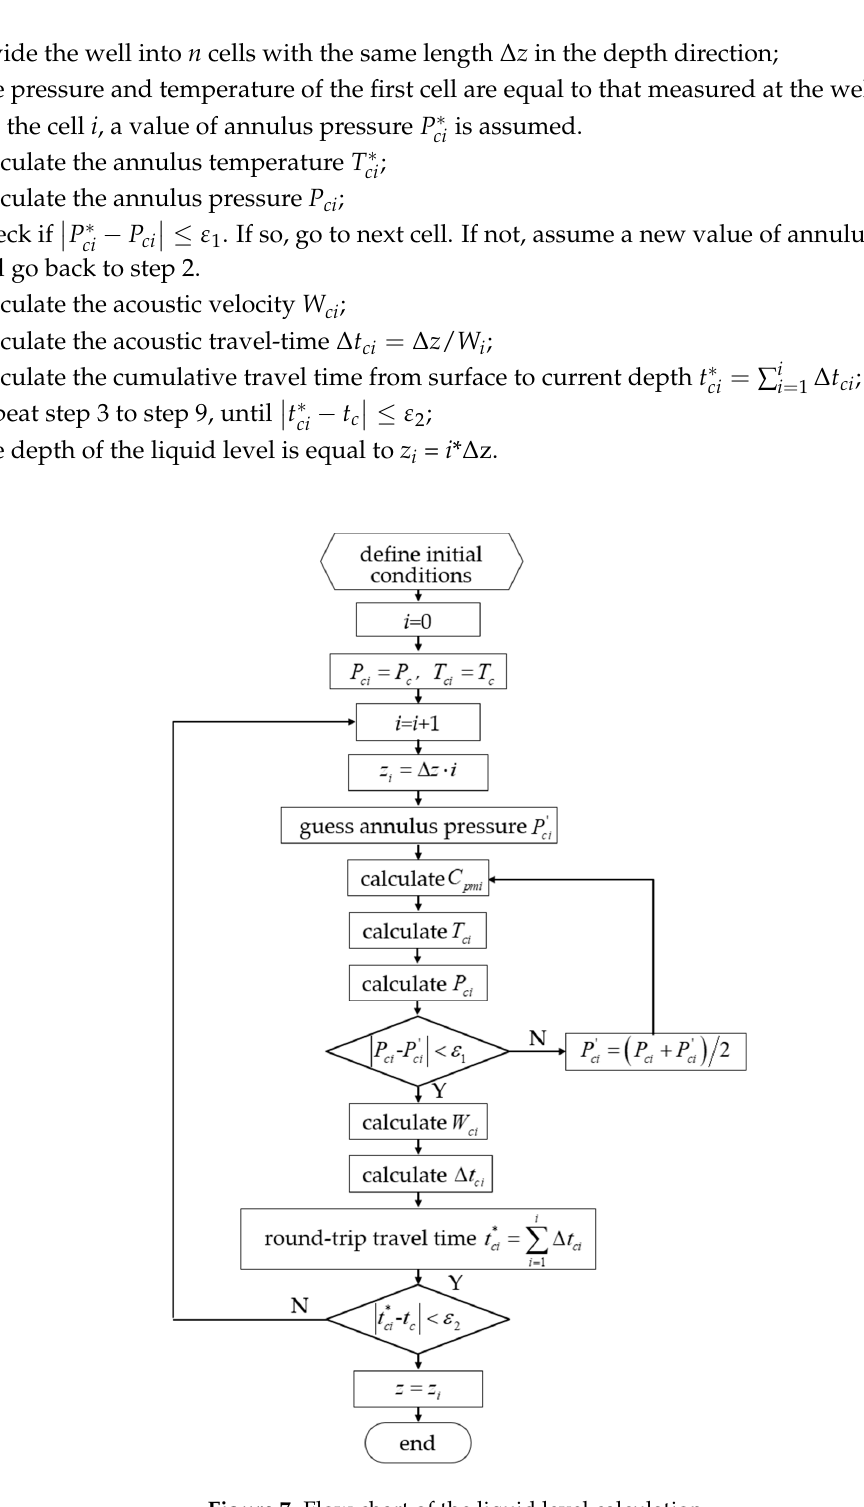
Figure 7. Flow chart of the liquid level calculation.